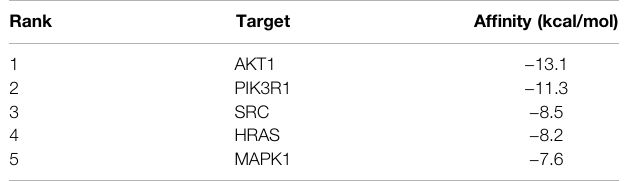
TABLE 2 | Different binding energies of celastrol polysul fi des with 5 selected